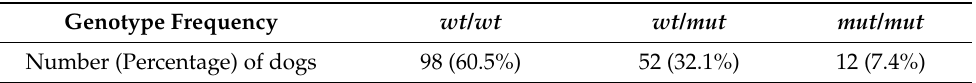
Table 2. Genotype distribution at the ACADM frameshift variant in 162